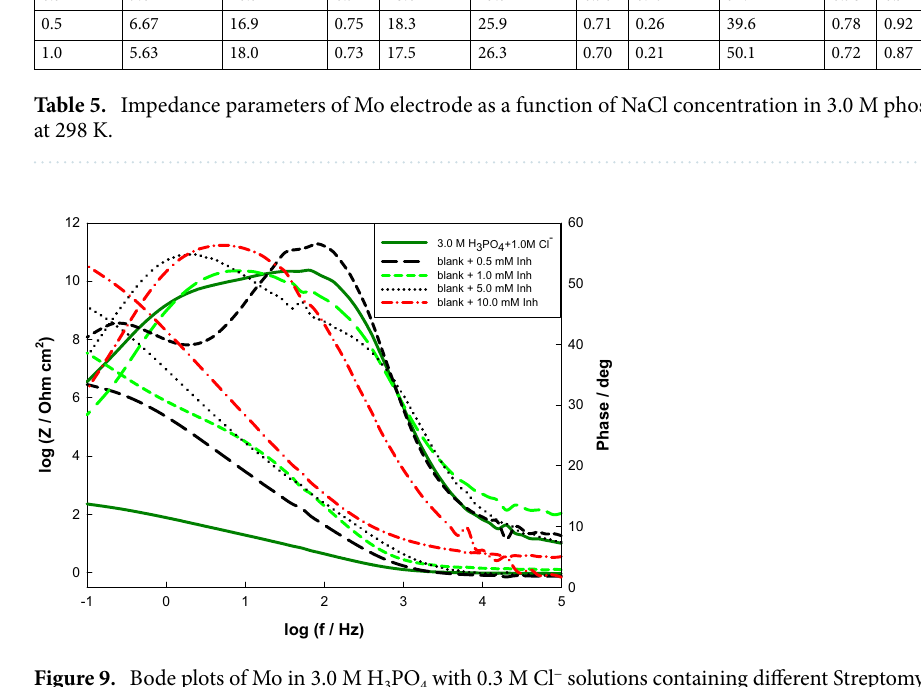
Figure 9. Bode plots of Mo in 3.0 M H 3 PO 4 with 0.3 M Cl − solutions containing different Streptomycin concentrations at 298